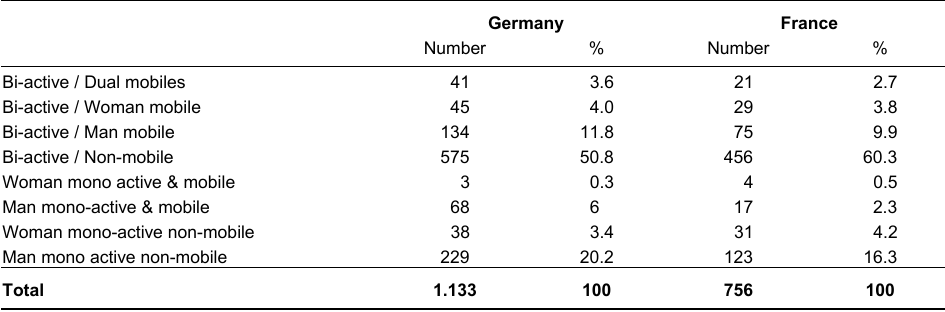
Germany France Number % Number %